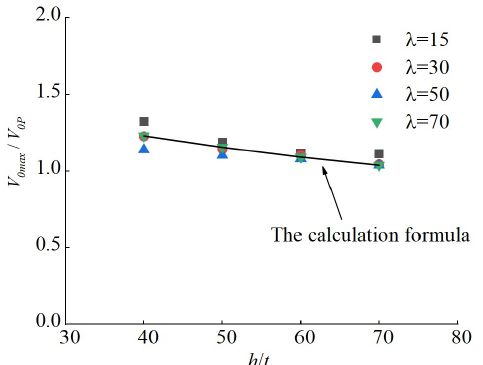
Figure 15. Definition of characteristic points of the skeleton curve.